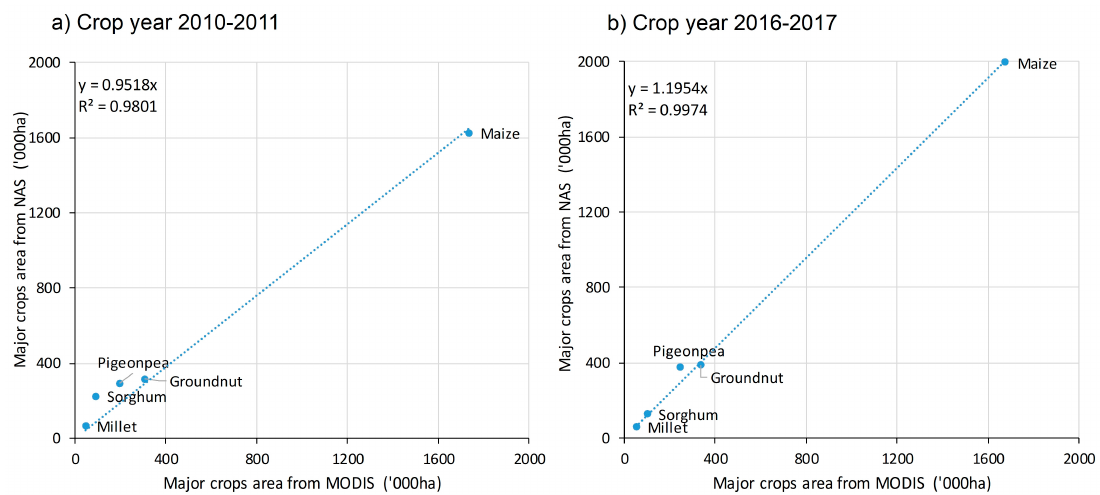
Figure 7. State-level cropland areas derived using MODIS time series data compared with FAO statistics data for agricultural year 2010–2011 and 2016–2017. Figure 8. Producer price of pigeonpea in Malawi, 1996–2016.